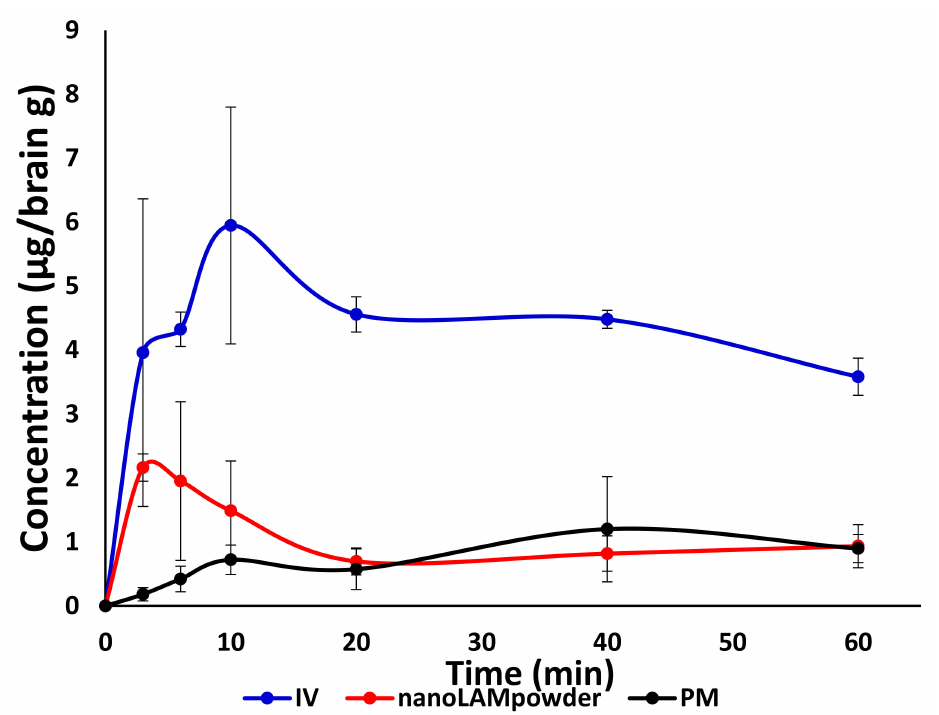
Figure 8. The concentration values of LAM in the brain